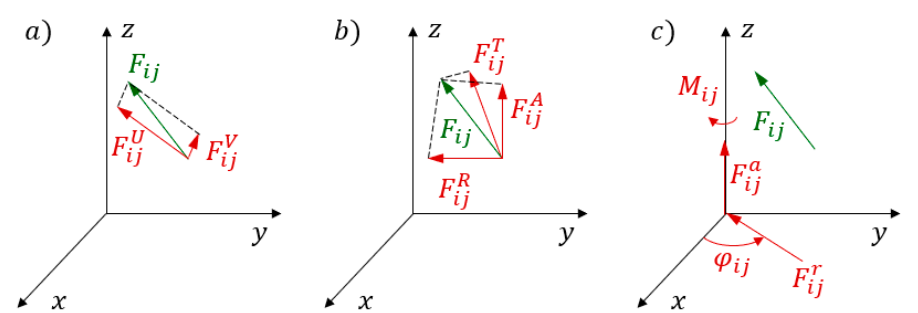
Figure 3. Coordinate system transformation of load microelement. ( a ) the load in the chip flow ( U , V ) coordinates. ( b ) the load in the Radial-Tangential-Axial (RTA) coordinates of the tool. ( c ) the load in the spindle reference (RAT) coordinate.